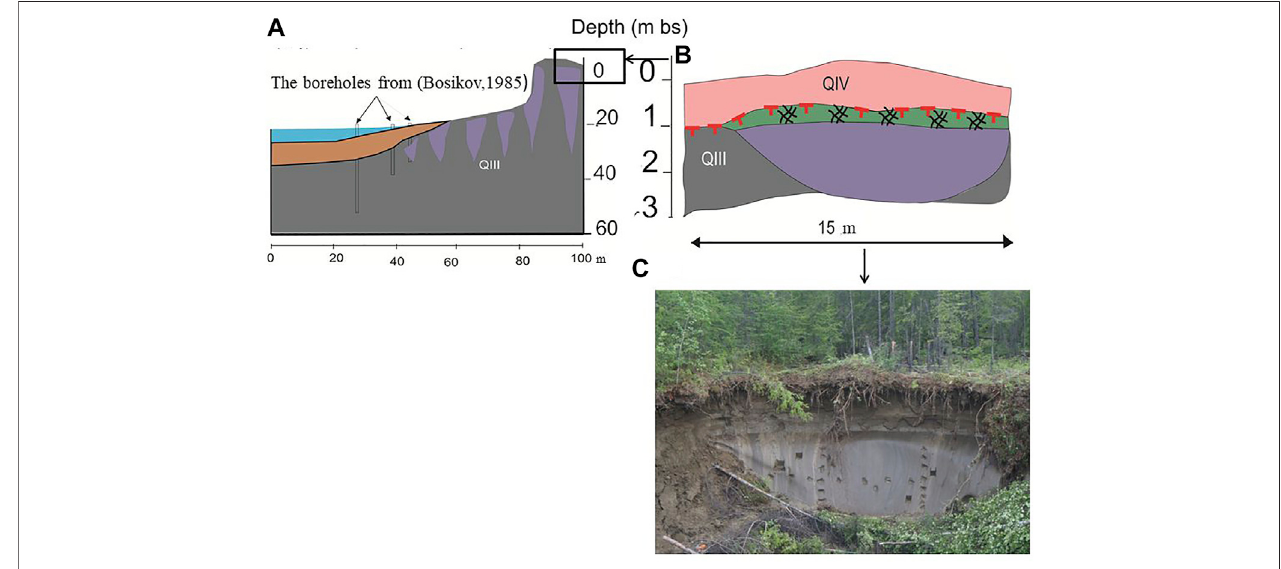
FIGURE 3 | Geological section of the Syrdakh Ice Complex: (A) schematic section of the coastal slope with archival boreholes (Bosikov, 1985); (B) geological section of the outcrop exposed in a thermo-erosional gully (C) the photo of the outcrop (by M. Cherbunina). Legend for the fi gure, see above ( Figure 2 ).